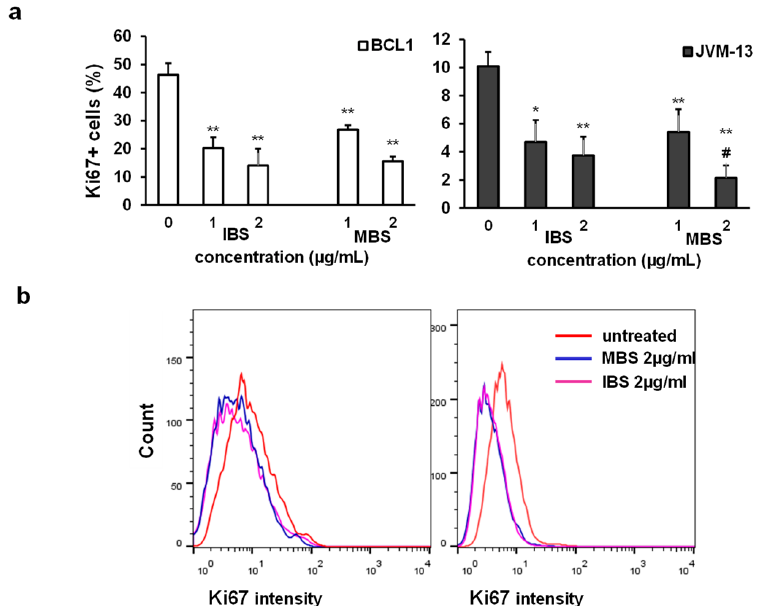
Figure 3. IBS and MBS attenuate the expression of Ki67 in BCL1 and JVM-13 cells. ( a ) Percentage of Ki-67 positive BCL1 and JVM-13 cells exposed to IBS and MBS (concentrations = 1 and 2 µ g/mL) for 24 h determined by flow cytometry presented as the mean + SD from three independent experiments. Data were analyzed with Student’s t -test: * p < 0.05; ** p < 0.01, # p < 0.05 (indicates differences between two doses of MBS). ( b ) Representative histograms of Ki67 expression (mean fluorescence intensity) in BCL1 and JVM-13 cells.